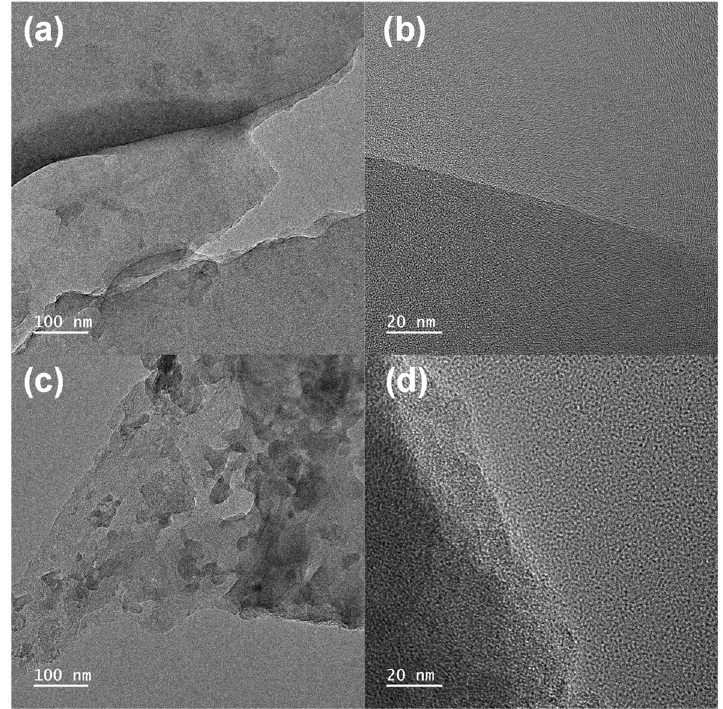
Figure 2. TEM images of BTC at ( a , b ) 600 °C and ( c , d ) 700 °C.